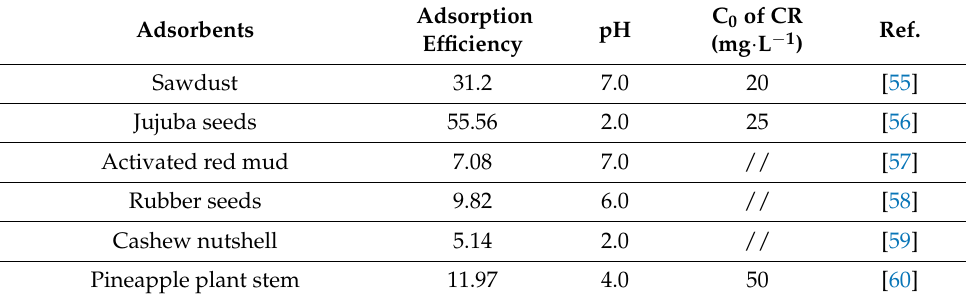
Table 4. Adsorption efficiencies (%) of Congo Red (CR) dye on several adsorbents.